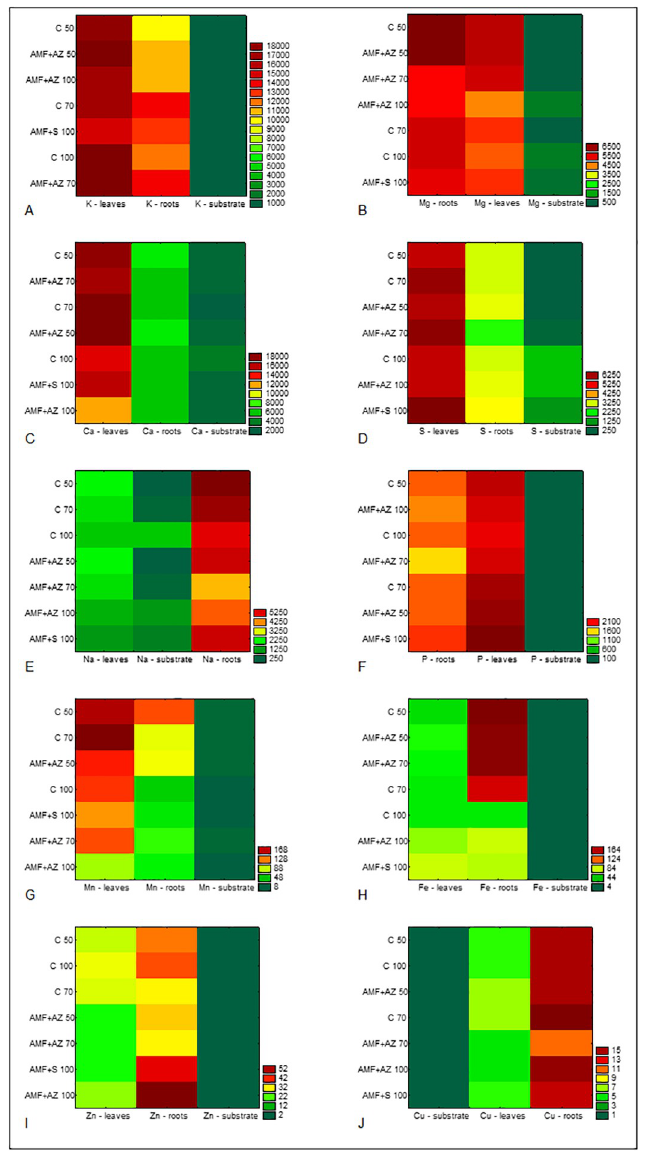
Fig 8. Heat map plots of elements content in soil/plant system under different substrate treatments: Potassium (A), magnesium (B), calcium (C), sulfur (D), sodium (E), phosphorus (F), manganese (G), iron (H), zinc (I), and copper (J). Green colors indicate that element contents were less than the means, while red colors indicate that element contents were higher than the means. C 50 –peat:sand ratio 50:50 (v:v) without inoculation; C 70 –peat:sand ratio 70:30 (v:v) without inoculation; C 100 –peat:sand ratio 100:0 (v:v) without inoculation; AMF + AZ 50 –peat:sand ratio 50:50 (v:v) inoculated with arbuscular mycorrhizal fungi (AMF) and Azospirillum brasilense (AZ), AMF + AZ 70 –peat:sand ratio 70:30 (v:v) inoculated with AMF and AZ, AMF + AZ 100 –peat:sand ratio 100:0 (v:v) inoculated with AMF and AZ; AMF + S– 100 peat:sand ratio 100:0 (v:v) inoculated with AMF and Saccharothrix tamanrassetensis (S). Mg amount was in roots of plants grown in C 50 and AMF + AZ 50 substrates (Table 4, Fig 8C). The sulfur root:shoot ratio was the highest in plants collected from the C 70 treatment (2.09) followed by the AMF + AZ 100 and AMF + AZ 50 (1.89 and 1.80, respectively) (Fig 7). Tomato leaves collected from all substrates contained a higher amount of sulfur than roots,